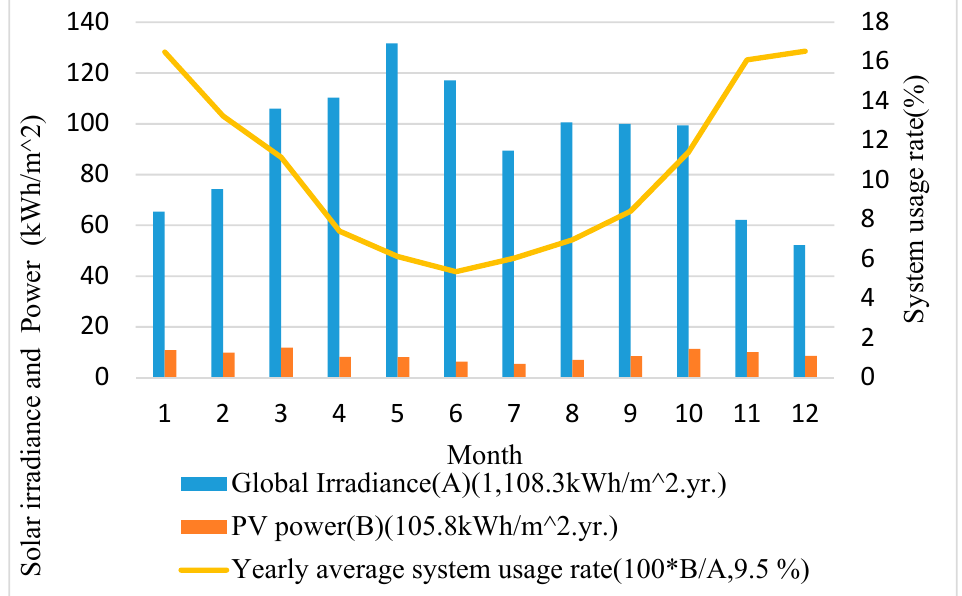
Figure 10. The system usage rate of the bi-facial BIPV module under the PV angle 90 ◦ . The system usage rate (100 × Power generation/Global irradiance) of the wall attached PV system shows just 5.4% in June which represents the highest solar altitude among 12 months. The yearly average system usage rate is also relatively low for these reasons, corresponding to 9.5%. Figure 11 shows the system usage rate depending on the PV module type (Bi-facial PV) and reflectance (0.1) of the PV cell under the PV angle 23.5 ◦ . The system usage rate of this PV system as a shade shows relatively uniform power distribution all year round independent of the solar altitude variation among the 12 months. The yearly average system usage rate is also relatively high for these reasons, corresponding to 17.6%. The increased power output caused by the uniform system usage rate (17.6%) of the bi-facial BIPV as a shade is 46% more than one by the low system usage rate (9.5%) of the wall attached bi-facial BIPV system, because bifacial PV cells can generate electrical power, not only through the front but also through the rear, coming from the wall surface, window, and surroundings, etc. These results are described as the ESR in Table 1. The global irradiance (105 kWh/m 2 ) in March is less than that (117 kWh/m 2 ) in June. Global irradiance/ESR (468.6 kWh/m 2 ) in June is 0.25. Global irradiance/ESR (300.6 kWh/m 2 ) in March is 0.35. Therefore, the system usage rate of March is slightly higher than that of June. A similar outcome as March is also shown in November. This kind of BIPV system as a shade can be very well combined with a bi-facial PV cell rather than a mono facial solar cell. As reflected light and scattered light reach the rear and the front of the bi-facial solar cell, the module contributes to the power generation output, and the daily power at the same time as the instantaneous maximum power value increases. This is why most